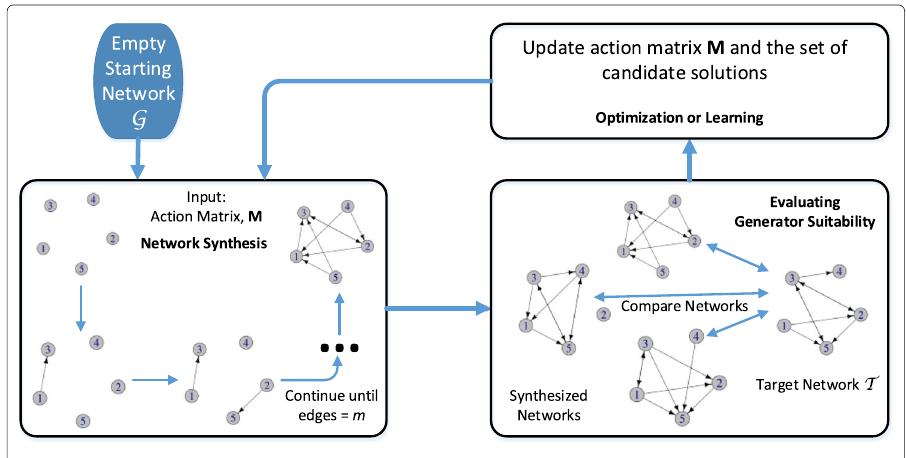
Fig. 1 A procedure for determining action matrix M : Network Synthesis probabilistically adds the required number of edges starting from an empty network. Evaluating Generator Suitability compares a set of synthesized networks to the target using the user-defined structural characteristics in order to determine the representativeness of action matrix M . Finally using Optimization or Learning the action matrix M is perturbed, and a set of best-fit solutions are retained. The process repeats until a termination criterion (e.g., number of iterations) is